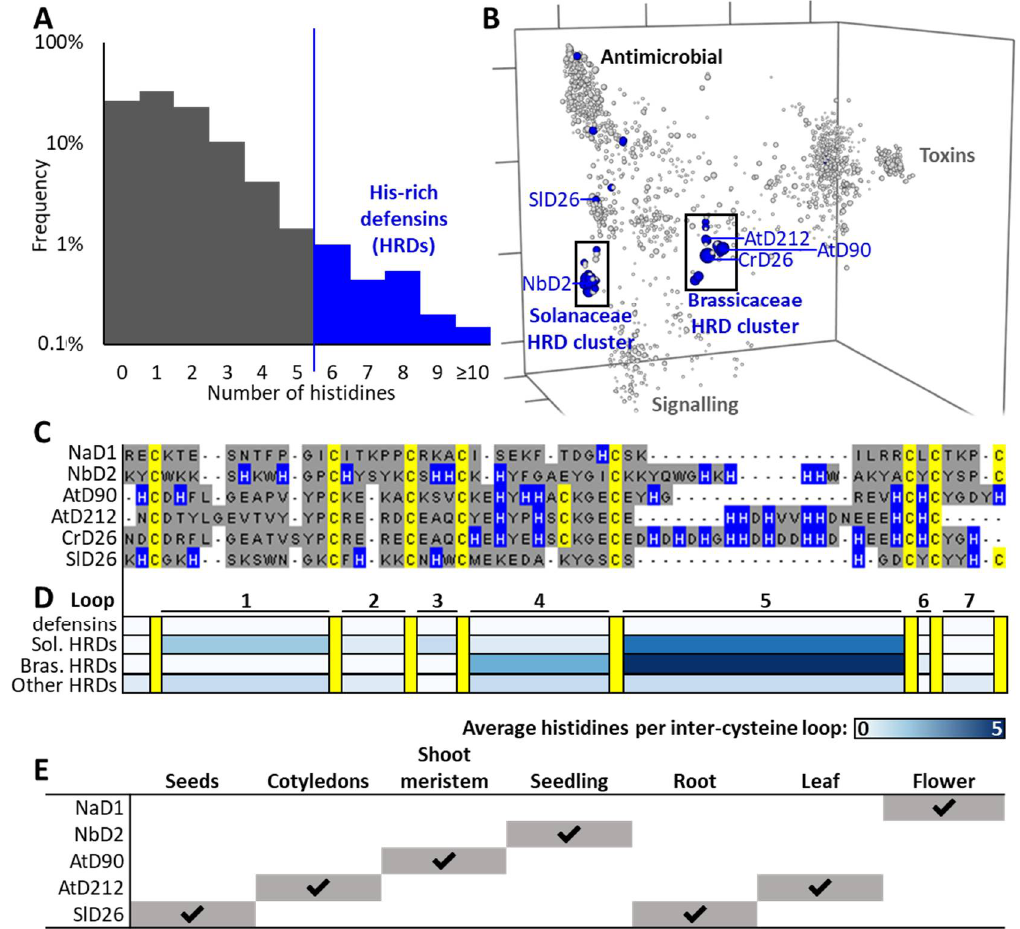
Figure 1. Histidine-rich defensins (HRDs) are a rare subset of the plant defensins. ( A ) Histidine- frequency in plant defensins (log scale). Grey shading represents the bulk of defensin sequences. Blue represents sequences identified as histidine rich. ( B ) Sequence space of 1901 defensins with HRDs ( ≥ 6 His) highlighted in blue. ( C ) Multiple sequence alignment of five example HRDs and a